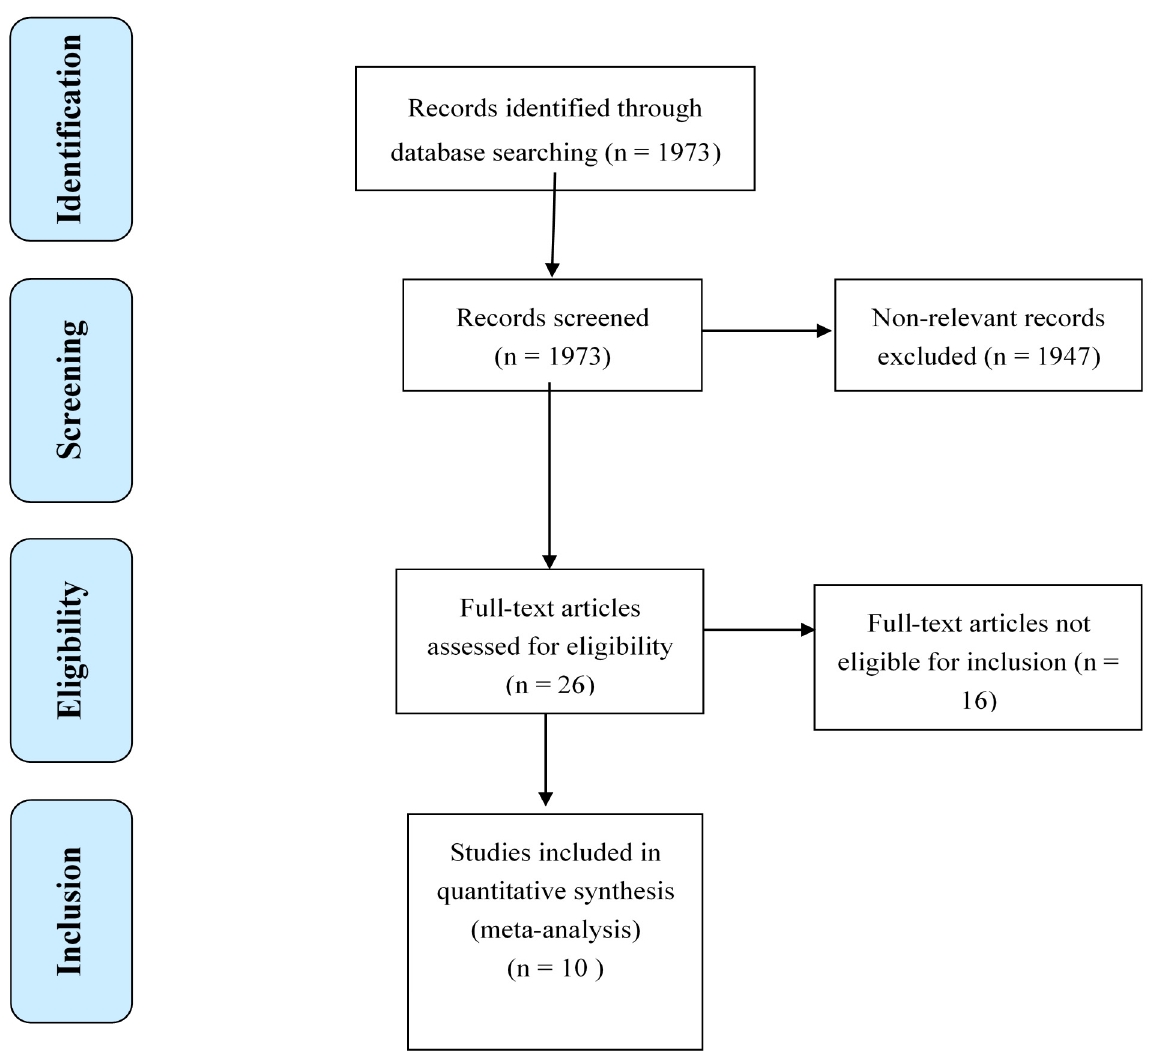
Figure 1. Flowchart of the systematic review and meta-analysis according to the PRISMA guidelines. The total number of participants included in this review was 5666 ranging from 47 to 1200. The overall mean age was 71.1 ± 3.2 years for all included studies. Only six countries have reported the prevalence of frailty including Saudi Arabia, Turkey, Lebanon, Egypt, Iran, and the United Arab Emirates (UAE). The total prevalence rate ranged from 4.41 to 81.3 (Table 1).